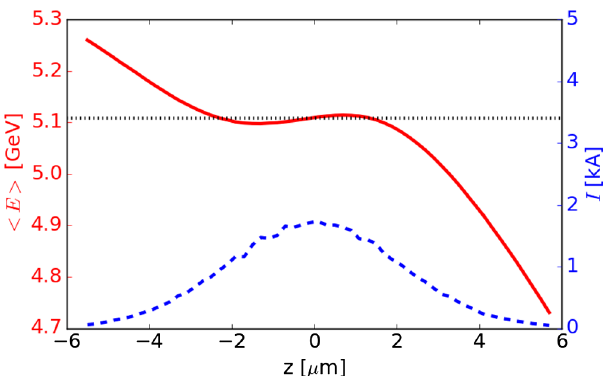
FIG. 9. Final beam current (blue dashed line) and average beam energy (red solid line) in each 0 . 2 μ m long slice. The reference energy is given by the black dotted line.